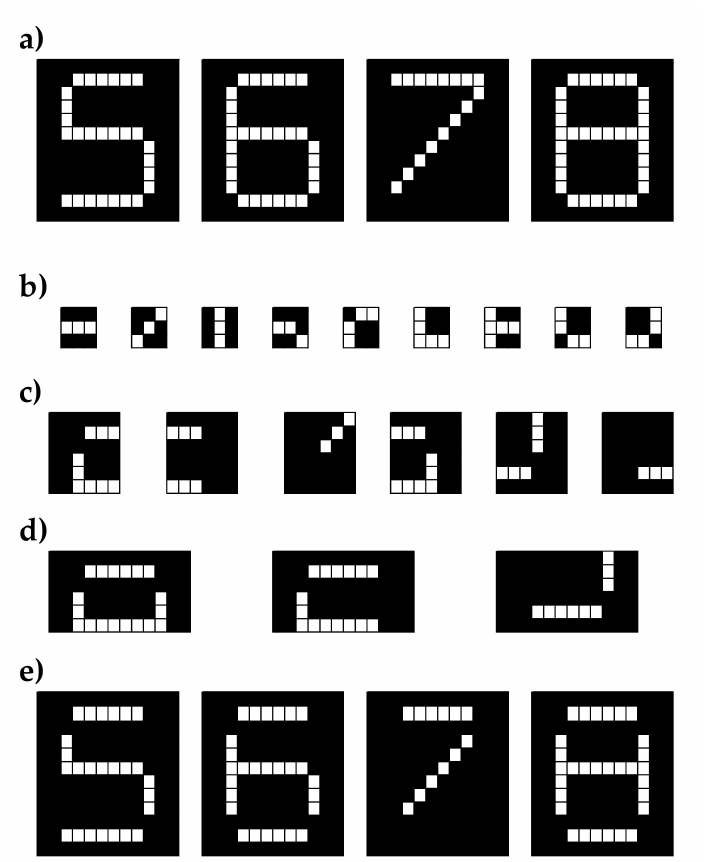
Figure 8. ( a ) Four numbers used as inputs for the training of the network. Learned patterns of ( b ) CL1, ( c ) CL2 and ( d ) CL3. ( e ) The abstract version of the digits that the network